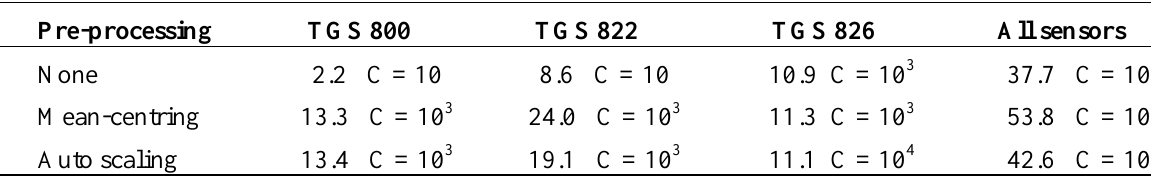
Table 2. Success rate in the simultaneous identification and quantification of vapours (%) using the steady state sensor response. Validation results are reported. The optimal value of parameter C is also